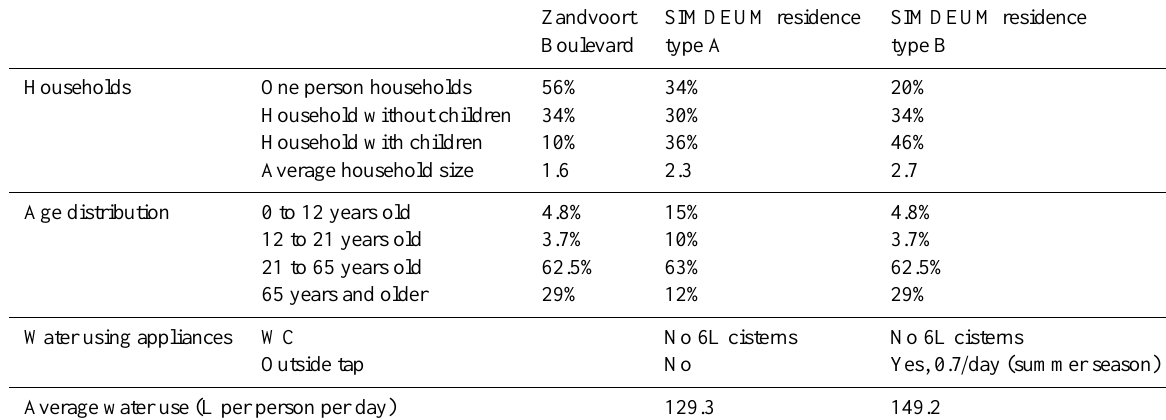
Water using appliances WC No 6L cisterns Outside tap No Average water use (L per person per